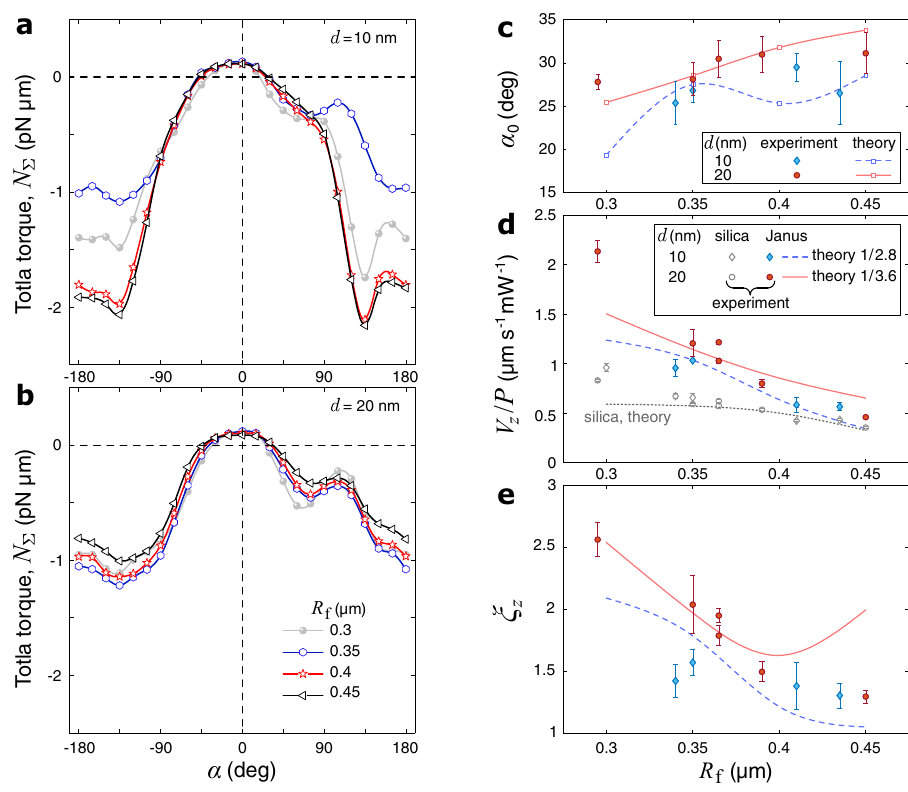
Fig. 5 | Validation of theoretical model. a , b Simulated torque on a JP versus the goldcaporientationforvariousONFradii, R f . c Measured(markerswitherrorbars) andsimulated(markersconnectedviaasplineinterpolation)balanceorientationas a function of R f for 10- and 20-nm-thick gold coating. d Measured (markers with error bars) and simulated (lines) propulsion speed (reduced by the transmitted ONF power, P =50 mW) for Janus and silica particles, as a function of the ONF